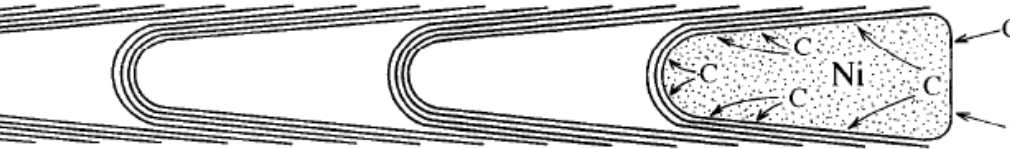
Figure 16. ( a ) TEM images of BCNTs with complete knots. ( b ) TEM images of BNCTs with incom- plete knots [62].